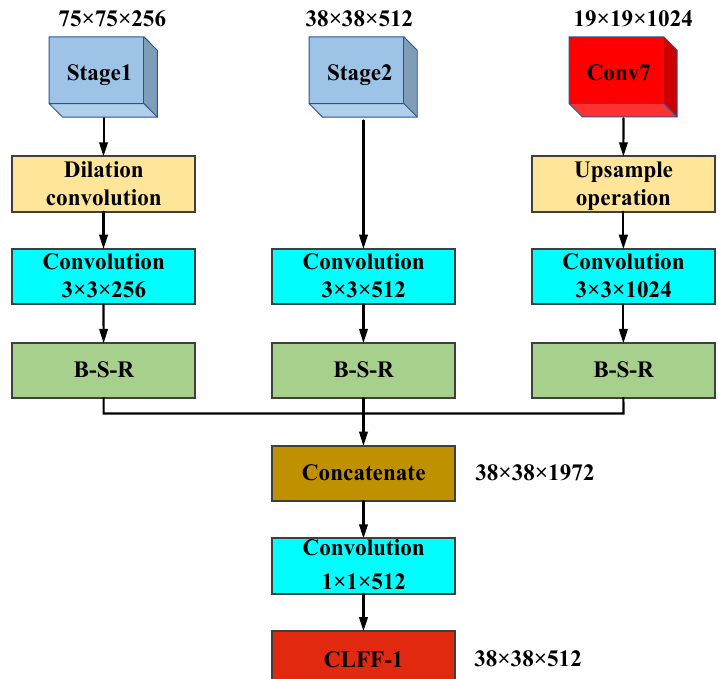
Figure 5. Schematic diagram of Cross-layer feature fusion-1(CLFF-1).